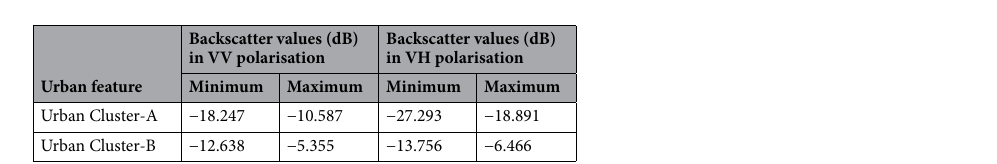
Table 13. Summary of variations in backscatter values for urban settlement